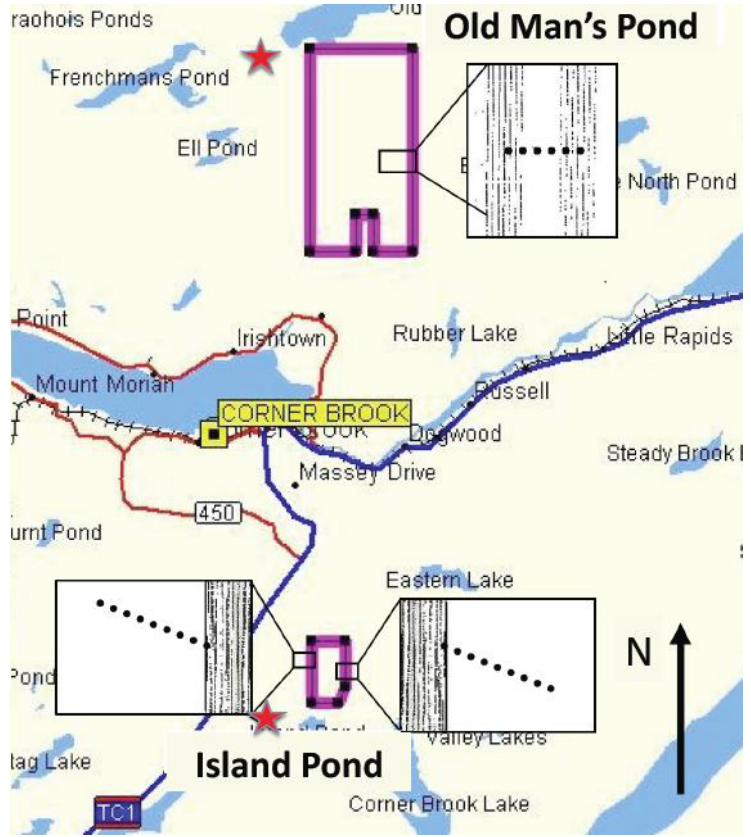
Figure 1. Map of area surrounding Corner Brook, NL, showing the location of Island Pond (cid:68)(cid:81)(cid:71)(cid:3) (cid:50)(cid:79)(cid:71)(cid:3) (cid:48)(cid:68)(cid:81)(cid:182)(cid:86)(cid:3) (cid:51)(cid:82)(cid:81)(cid:71)(cid:3) (cid:49)(cid:72)(cid:68)(cid:69)(cid:49)(cid:51)(cid:57) -treatment blocks in 2002. Insets show the locations of sampling transect lines (dotted lines) and aircraft spray tracts (dashed lines) at each location. Control blocks, which were located 1 (cid:177) 5 km from treatment blocks, are indicated with